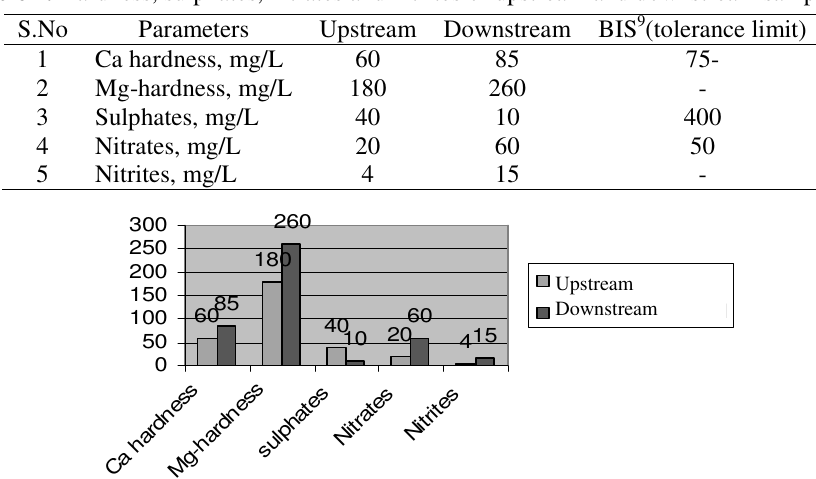
Table 4. Hardness, sulphates, nitrates and nitrites of upstream and downstream samples.